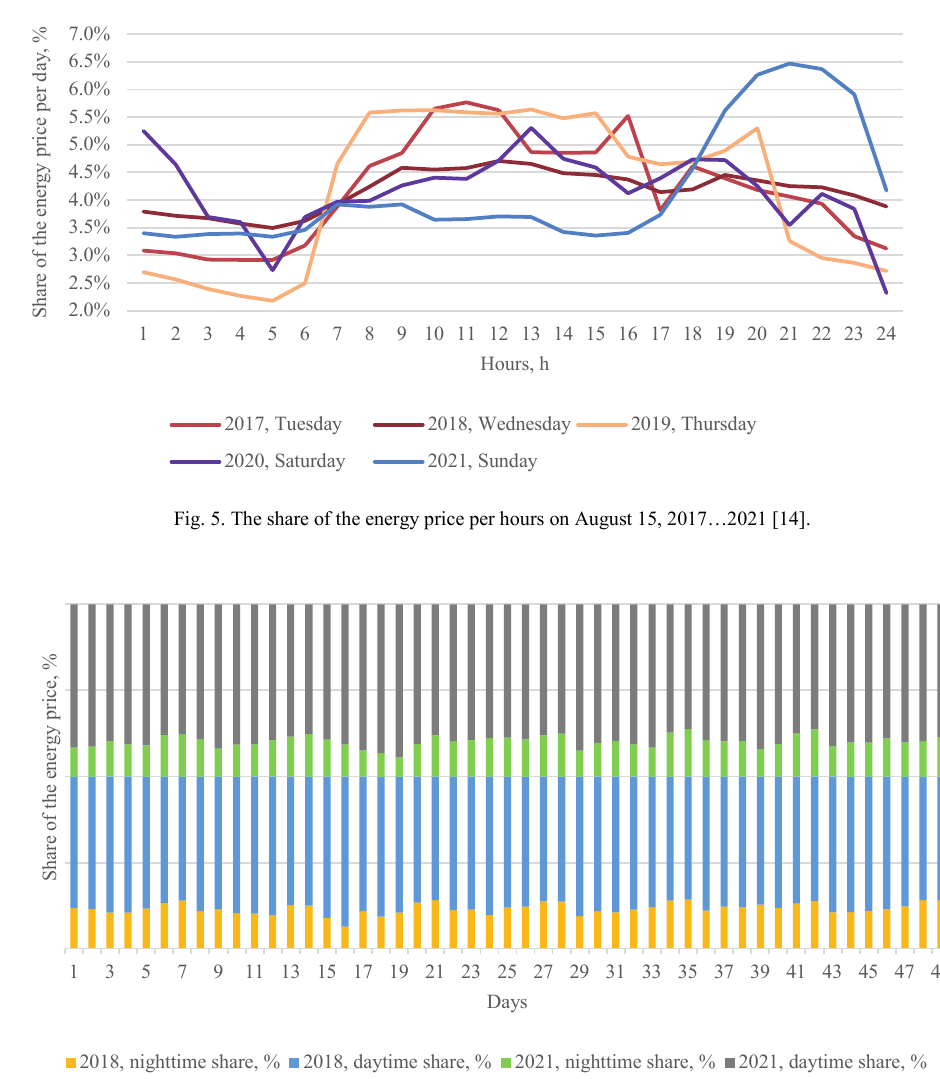
Fig. 6. The share of the energy price on night-time and daytime comparison during 04.01.–21.02.2022. The patterns in Fig. 6 show that the price of electricity at night has the highest share on Sundays in both